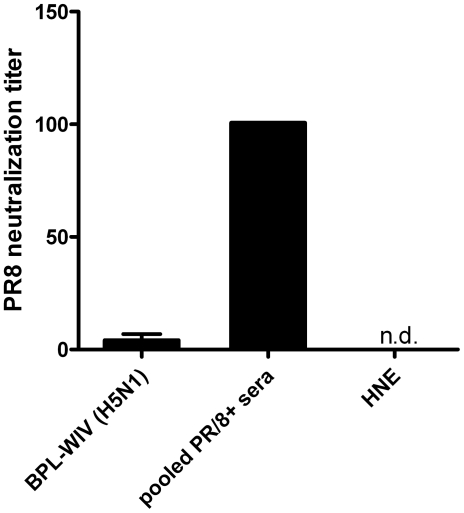
H1N1-neutralization antibodies measured in pre-challenge sera of mice vaccinated with H5N1 BPL-WIV.Bars indicate the geometric mean titers±SEM of 6 mice in the H5N1 BPL-WIV vaccination group or the titer measured in the pooled sera from 10 mice vaccinated with H1N1 PR/8-derived vaccine and challenged with PR/8 virus. Sera from mice vaccinated with H5N1 BPL-WIV showed very low neutralization activity against H1N1 PR/8.